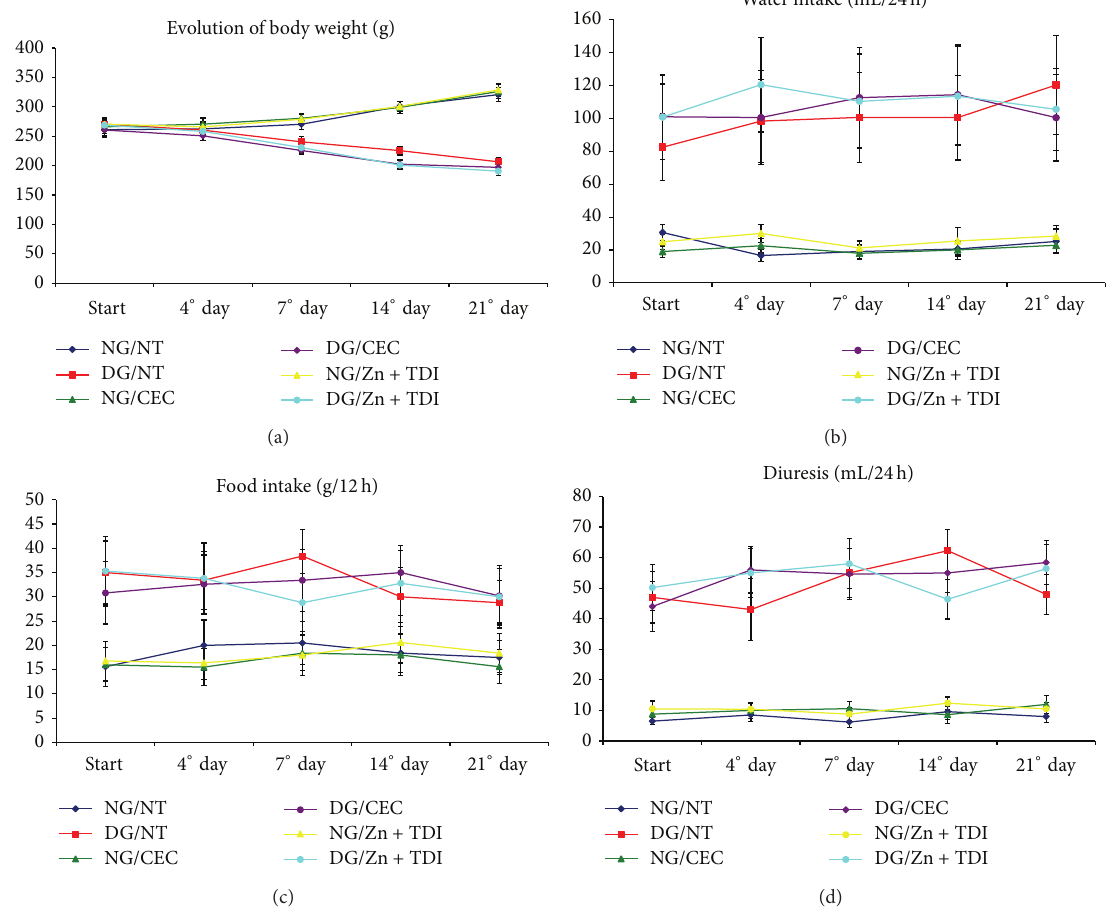
Figure 2: Graphs showing the variation of clinical parameters in six experimental groups during follow-up: (a) body weight (g); (b) water intake (mL/24h); (c) food intake (g/12h); (d) diuresis